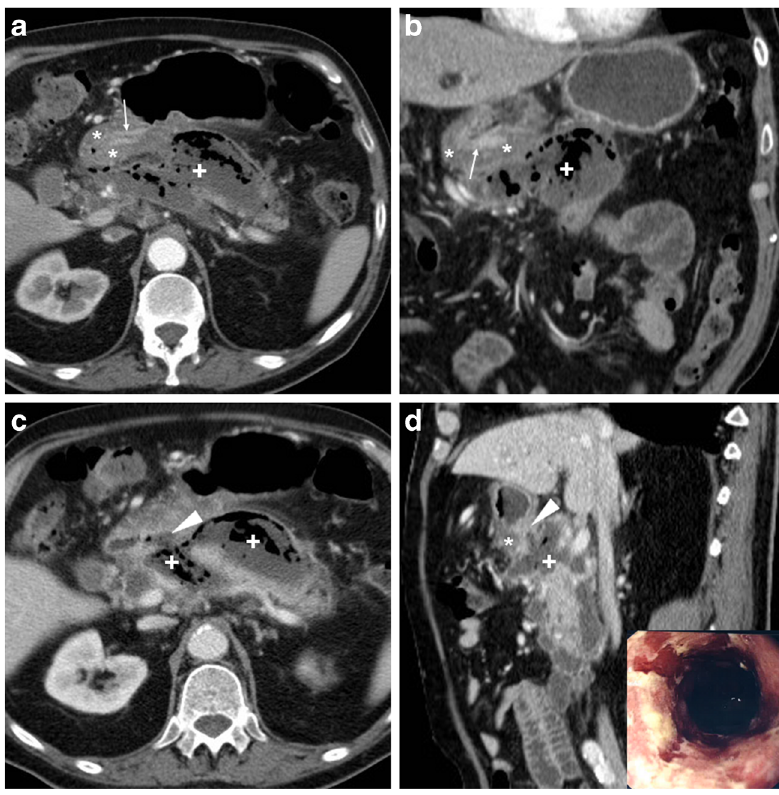
abscess andinflameddigestivetract. Thefistulisationsite corresponded to endoscopic finding (image in inset d ) of large posterior bulbar ulcer. Laparotomic surgery required extensive dissection, confirmed a vast, stinky purulent and necrotic collection, fixed to the stomach and deformed pylorus, and was completed with gastric resection and Billroth-II gastrojejunostomy. Pathology confirmed severe transmural ulcerated peptic gastro-duodenitis, without malignant changes [Adapted from Open Access ref. no